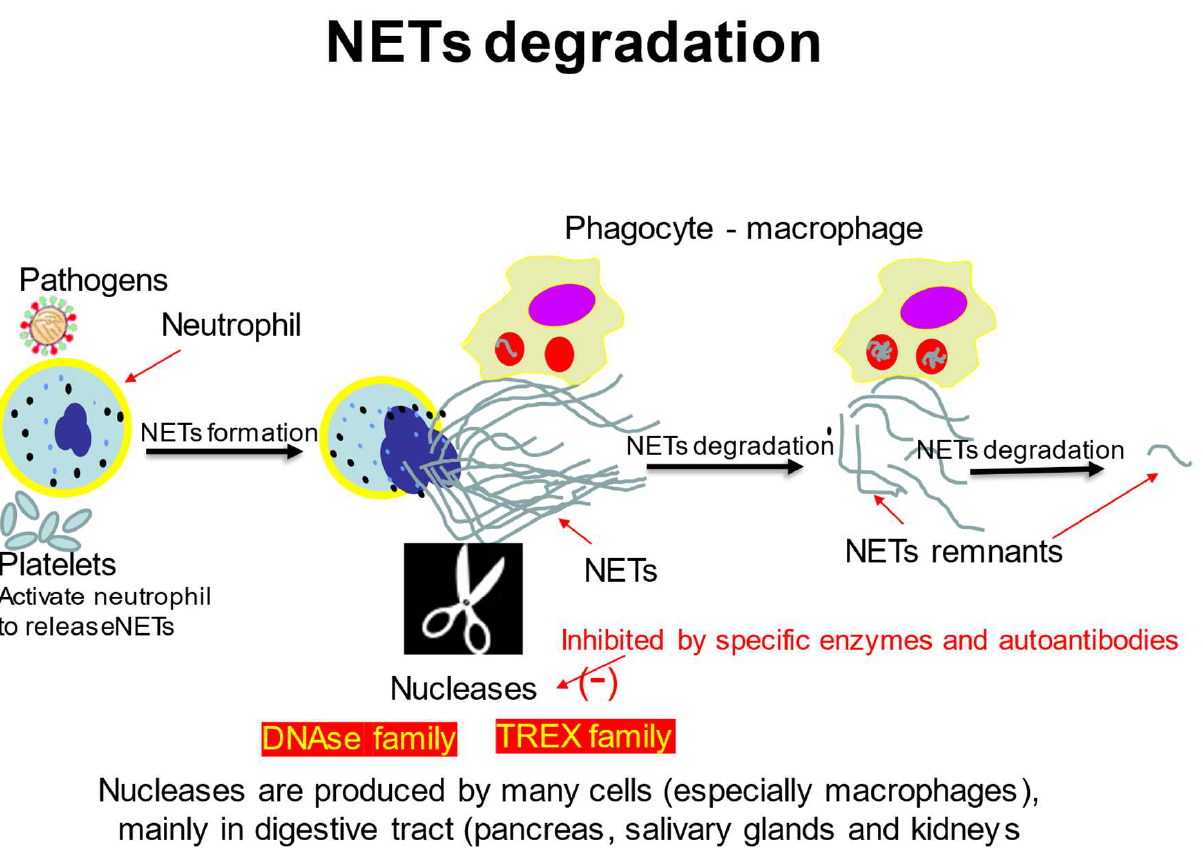
Figure 1. NETs degradation mechanisms.